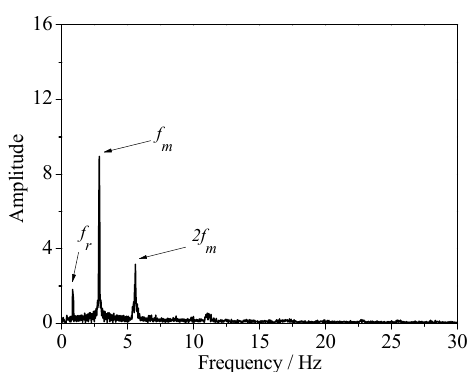
Figure 7. The frequency spectrum of torsional vibration of planetary gear.